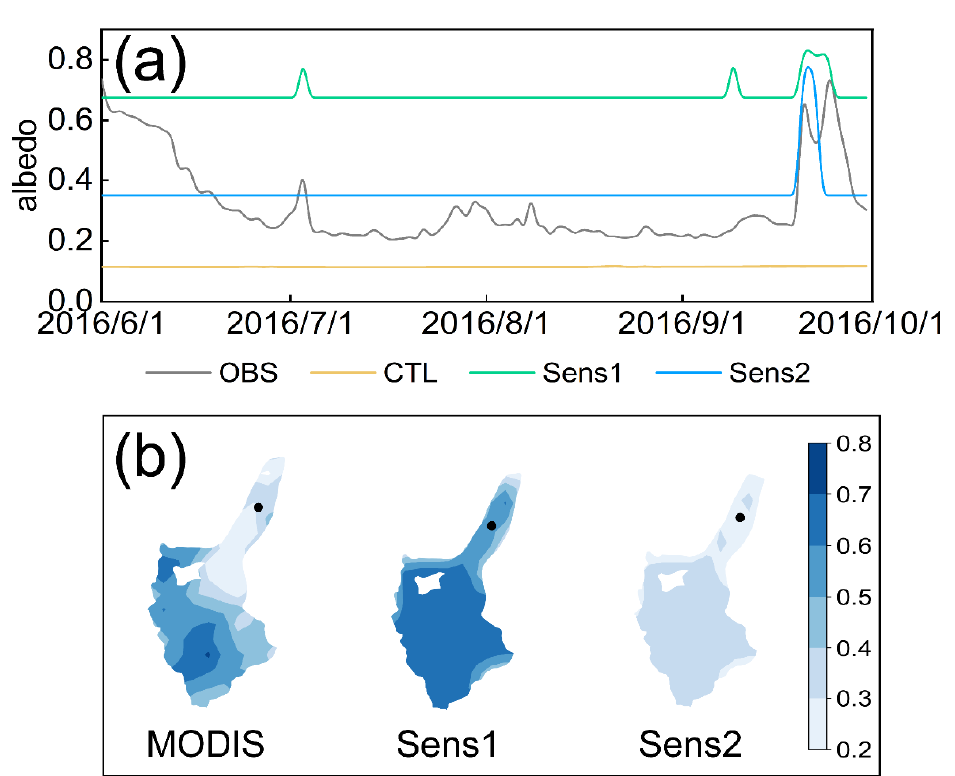
Figure 5. Comparison of model-estimated albedo at 14:00 LST against observations ( a ) and MODIS retrieved product on 21 August 2016 ( b ). The solid black circle indicates the location of the AWS.